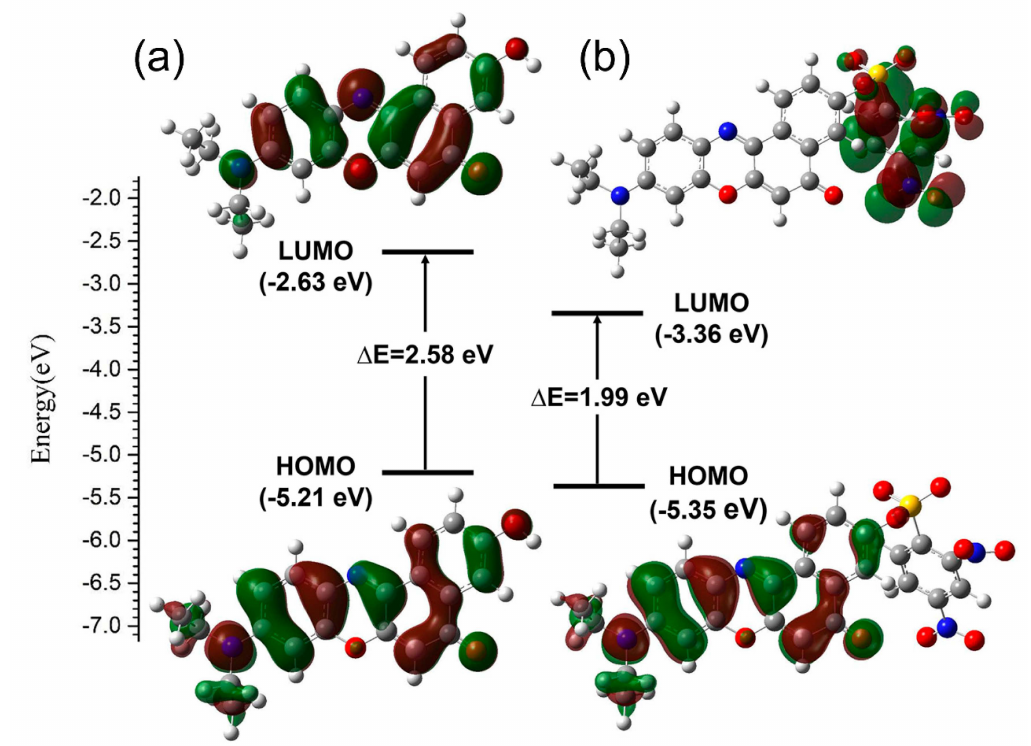
Figure 7. Molecular orbital diagrams and excitation energies of NR ( a ) and NRSH ( b ).